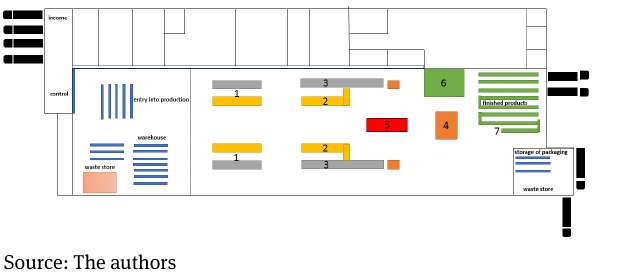
tudes of material flows. The diagram showed that the ma- terial flows often intersect the reverse flows of mixed and recyclable